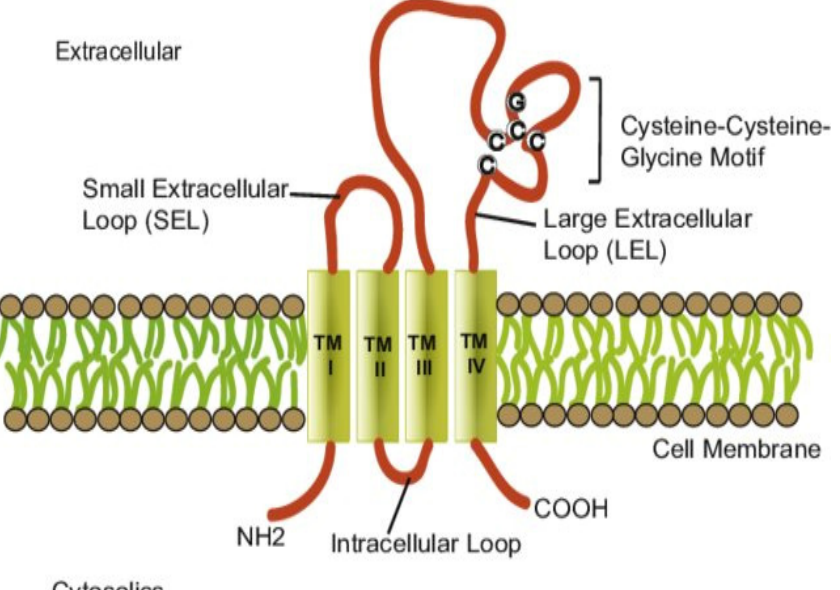
Figure 2. Tetraspanin structure: Four transmembrane domains (TMI-IV), a small extracellular loop, a large extracellular loop, and the intracellular loop with C-terminal and N-terminal regions. Reprinted with permission from [10].